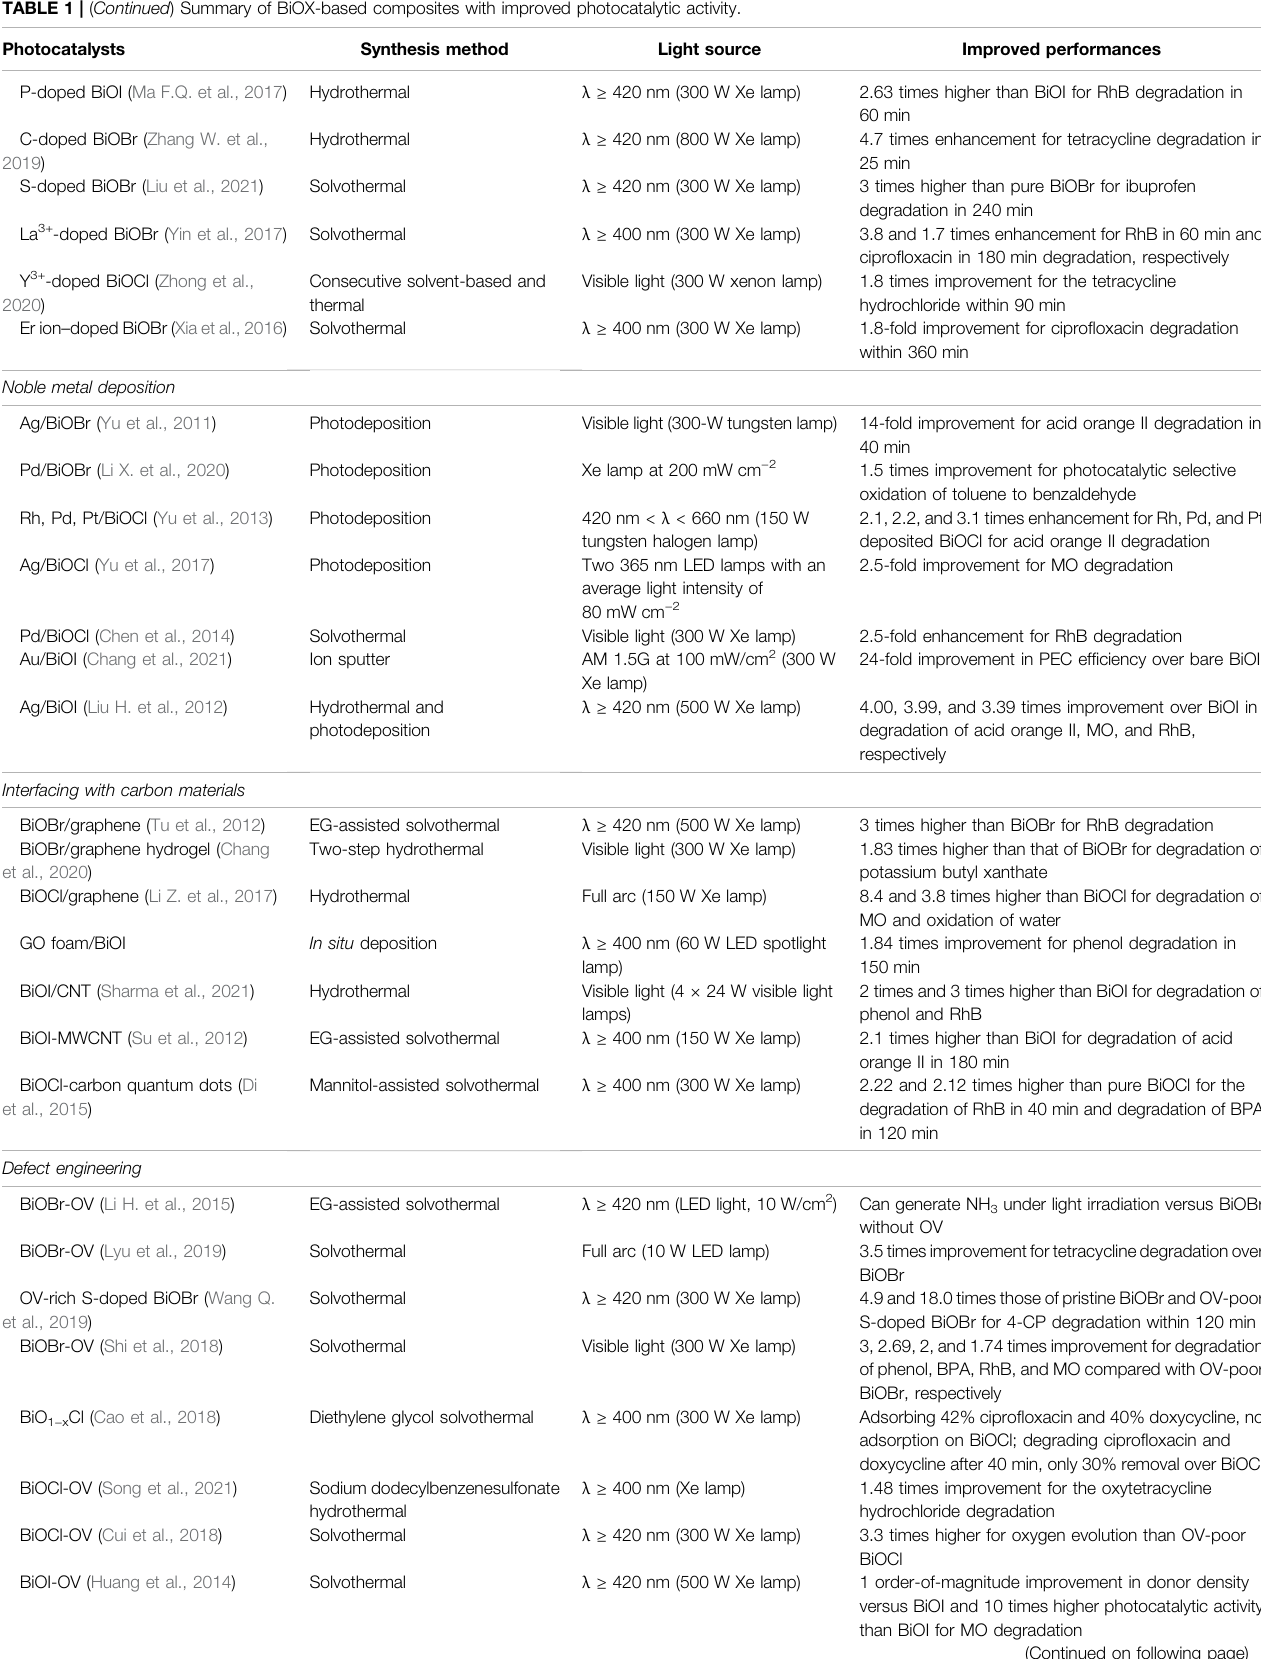
TABLE 1 | ( Continued ) Summary of BiOX-based composites with improved photocatalytic